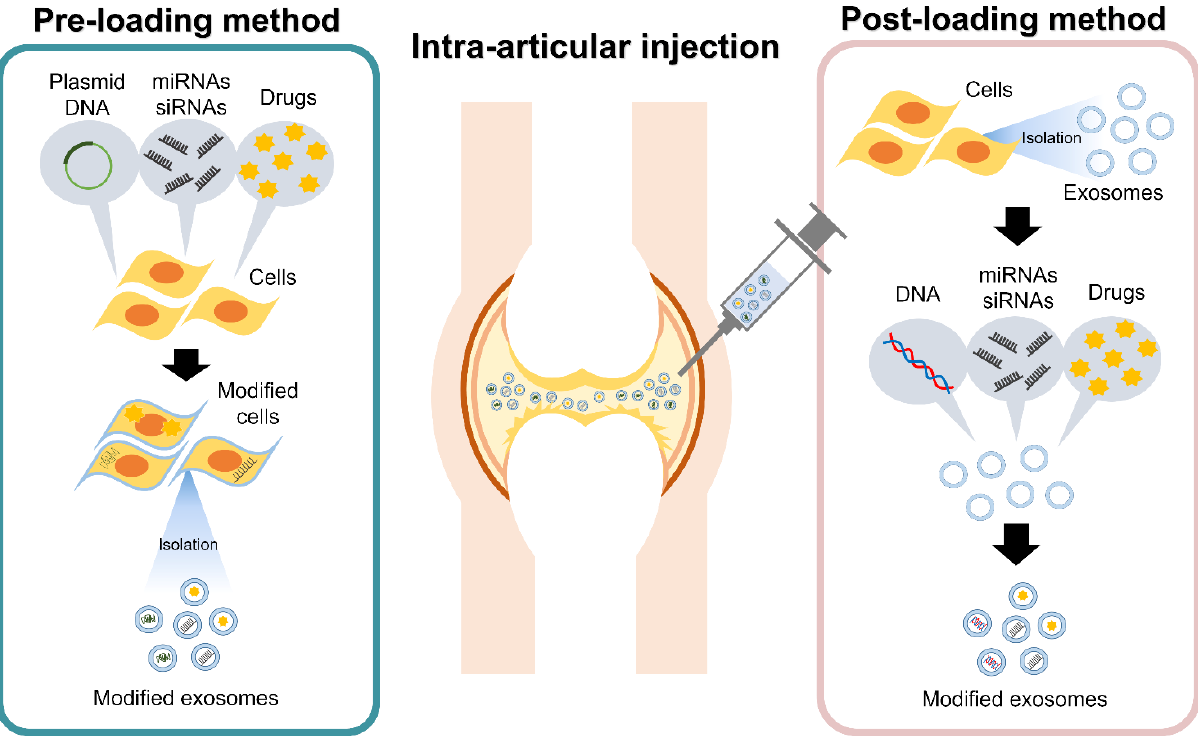
Figure 3. Intra-articular treatments utilizing modified exosomes as a drug delivery system. The loading of specific components into exosomes can be conducted either before exosome isolation (pre-loading method) or after exosome isolation (post-loading method).